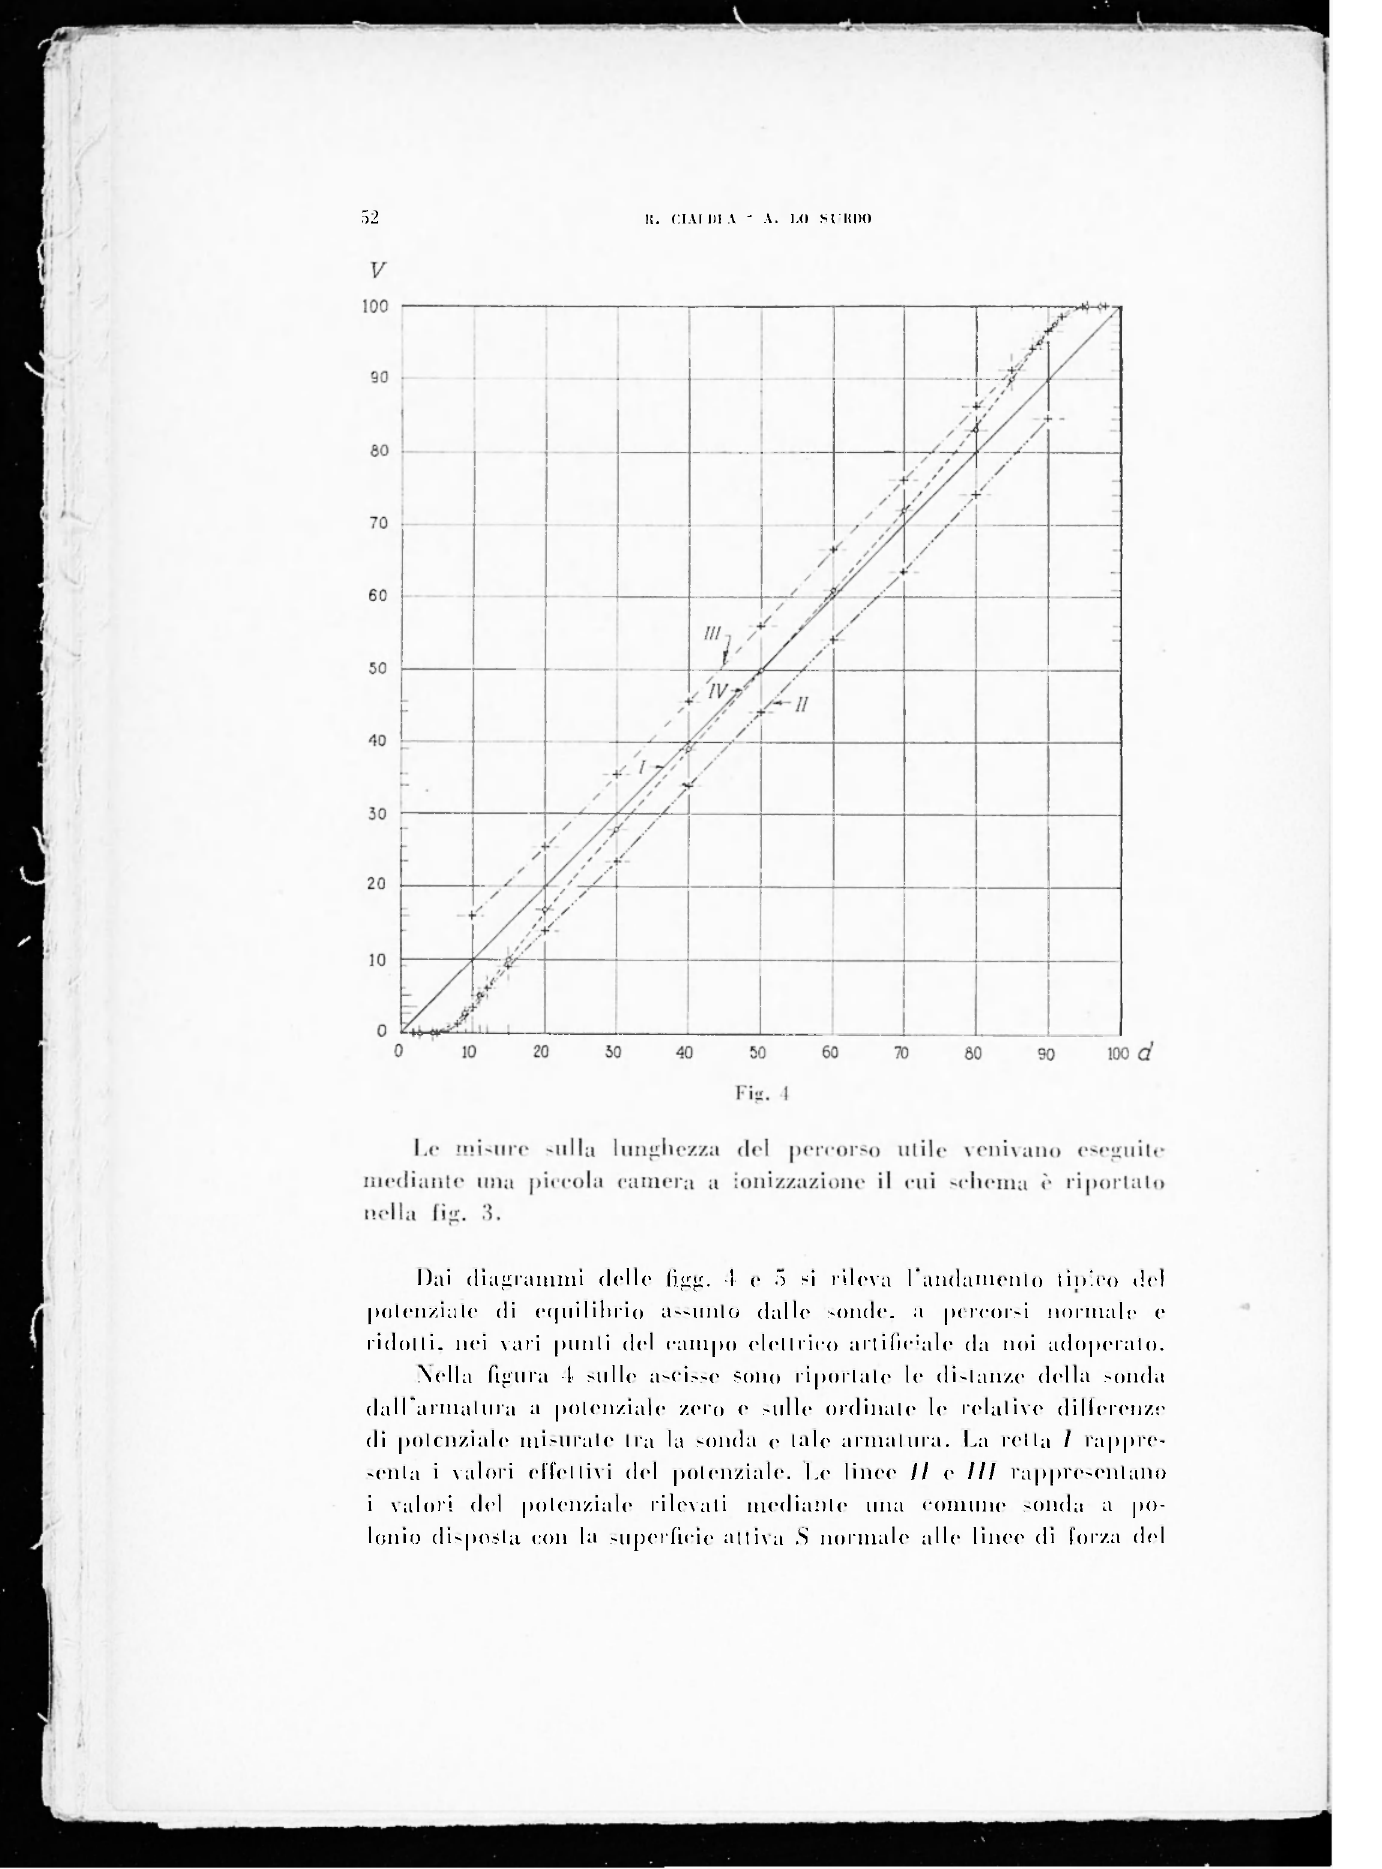
Dai diagrammi delle figg. 1 e ó si rileva l'andamento ùnico del potenziate di equilibrio assunto dalle sonde, a percorsi normale e ridotti, nei vari punti del campo elettrico artificiale da noi adoperalo. Nella figura 4 sulle ascisse sono riportate le distanze della